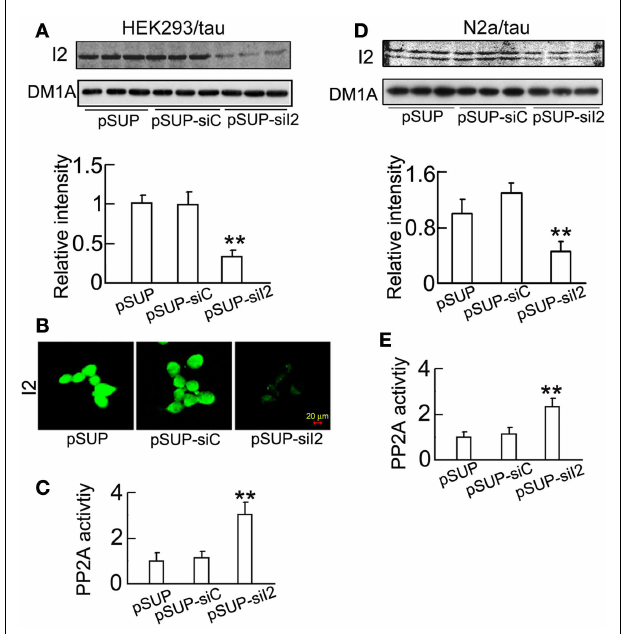
FIGURE 6 | SiI PP2A decreases the expression of I PP2A and increases PP2A 2 2 (pSUP-siI 2 ) was transfected into activity in cell lines . pSUP - siI PP2A 2 HEK293/tau or N2a/tau cells to knockdown the expression of I PP2A , pSUP, 2 and pSUP-siC were transfected as the controls. After 24h, the level of I PP2A 2 in the cell extracts was estimated byWestern blotting (A,D) and immunostaining (B) .The activity of PP2A was measured by a PP2A activity assay kit as described in the Section “Materials and Methods” (C,E) .The relative intensity was normalized against DM1A (to α -tubulin) and expressed by setting pSUP as 1.The data were presented as mean ± SD of at least three independent experiments. ** p < 0.01 vs.